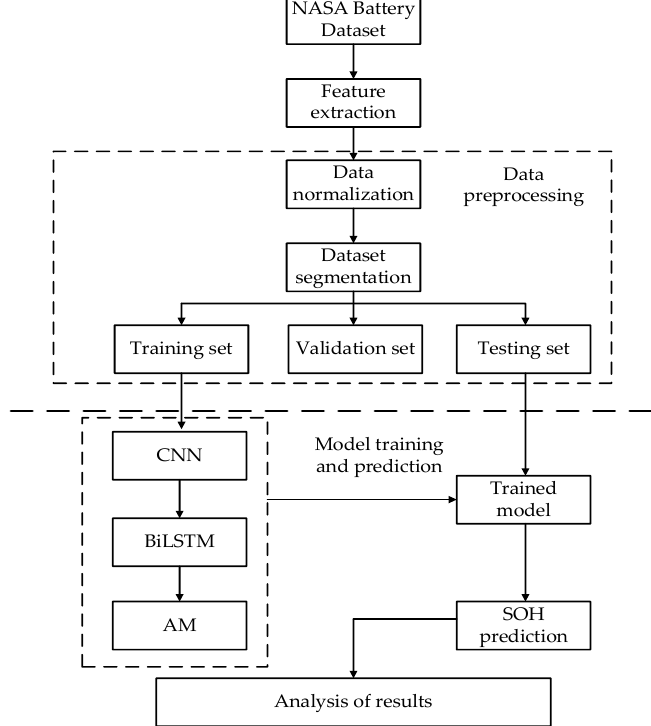
Figure 7. Flow chart of SOH prediction based on CNN-BiLSTM-AM model.